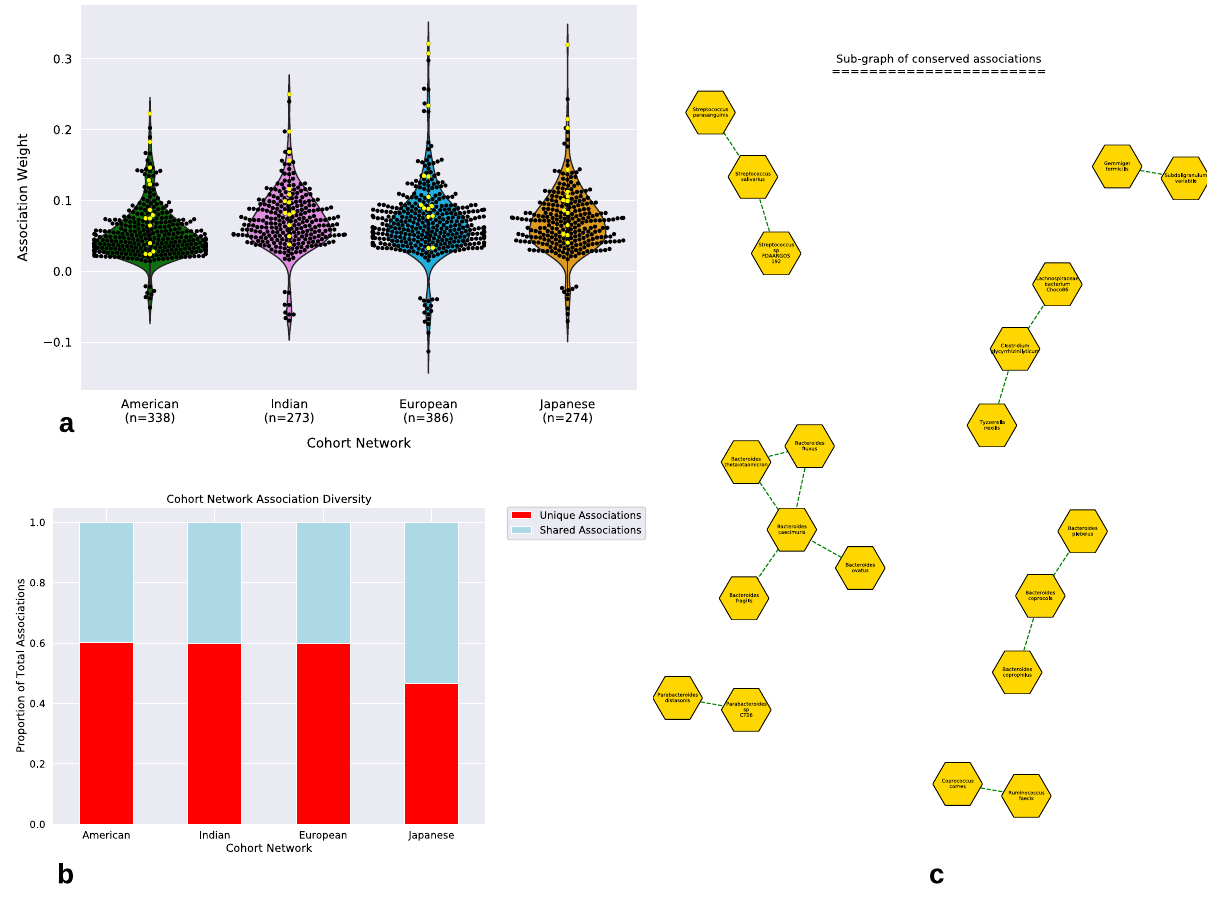
Figure 3. Cohort network association analysis. ( a ) The distribution of bacterial association weights within each cohort’s network, dots (black and yellow) and (n) represent total associations. Yellow dots represent species associations that were found shared across all networks. ( b ) The proportion of associations within each cohort’s network that are unique (red) or shared (blue) with at least one other network. ( c ) Sub-graph displaying only the 20 conserved nodes (species) and 14 edges (associations) retained across all